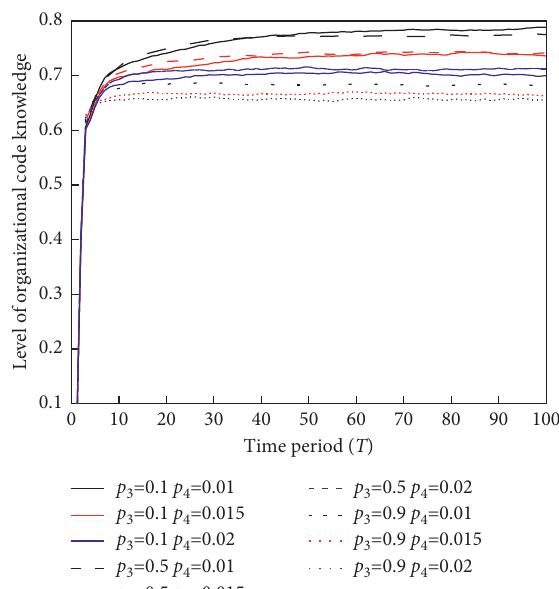
Figure 6: Effects of different combinations of the extent of environmental dynamism and system openness on organizational code knowledge over